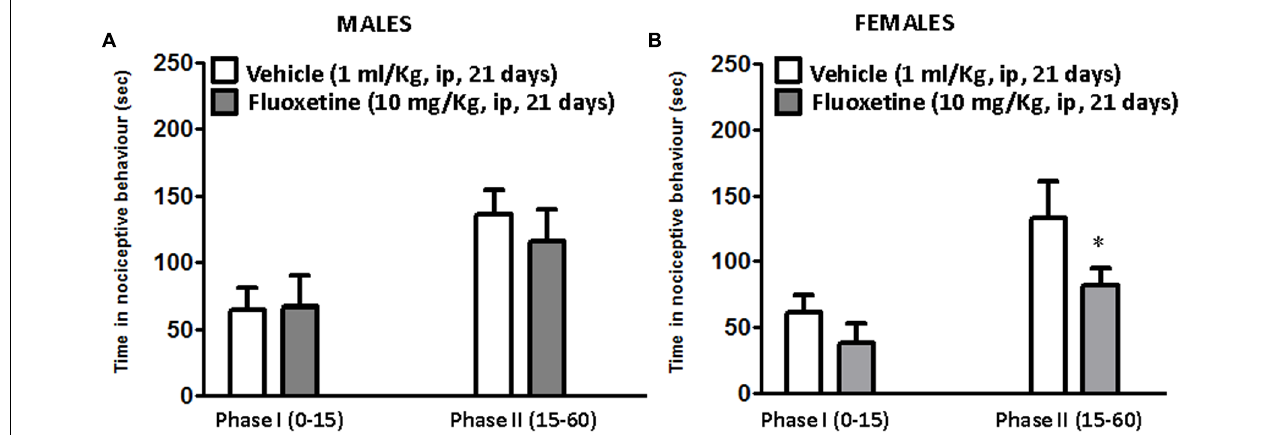
FIGURE 1 | Effects of chronic administration with fluoxetine in the formalin test in male and female CD1 mice. Chronic administration with fluoxetine (10 mg/Kg, i.p. for 21 days) fails to induce analgesia in male mice (A) but reduces the second phase of the formalin test in female CD1 mice (B) . Data are means ± SEM of 9 to 12 mice per sex/group. ∗ p < 0.05 versus the respective vehicle group (two tailed Student’s t -test).